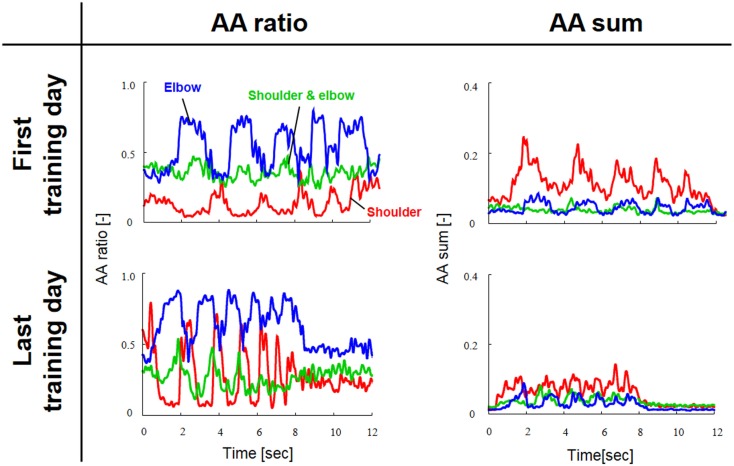
Typical change in agonist–antagonist (AA) ratios and AA sums from the first and last days of voluntary training (Subject #1). The red, green, and blue lines indicate the change in the time-dependent explanatory variable for the AA muscles around the shoulder, shoulder and elbow, and elbow joints, respectively. The AA ratio and AA sum oscillated over time in accordance with rhythmic limb movement. The changes in the AA ratio and AA sum indicate that the voluntary training resulted in a change in the control of EP and stiffness around each joint.